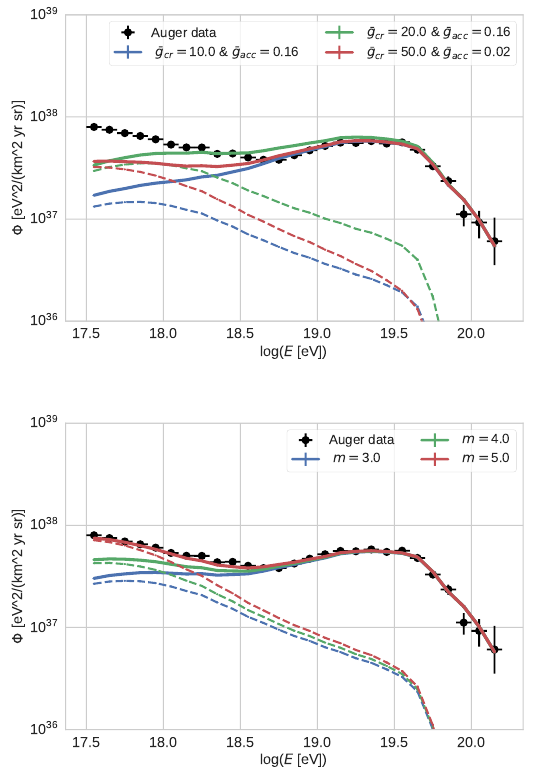
Figure 1. Contribution of the CSF (dashed line) on the total flux (solid line). The left figure shows three di ff erent parameter configurations in the case of a source evolution index m = 3. The right figure displays three di ff erent source evolution indexes, while the other parameters are chosen according to table 1. The observational data is taken from Auger [7].